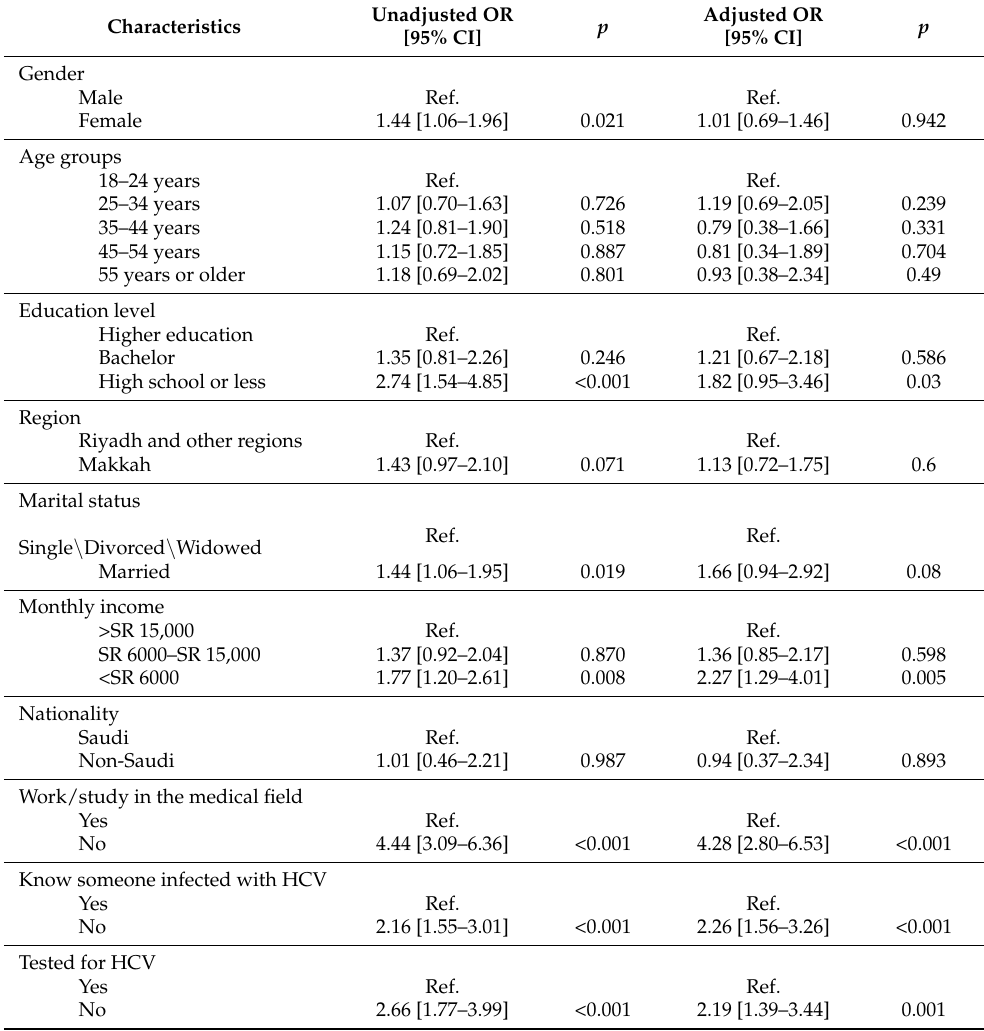
Table 4. Factors associated with low knowledge